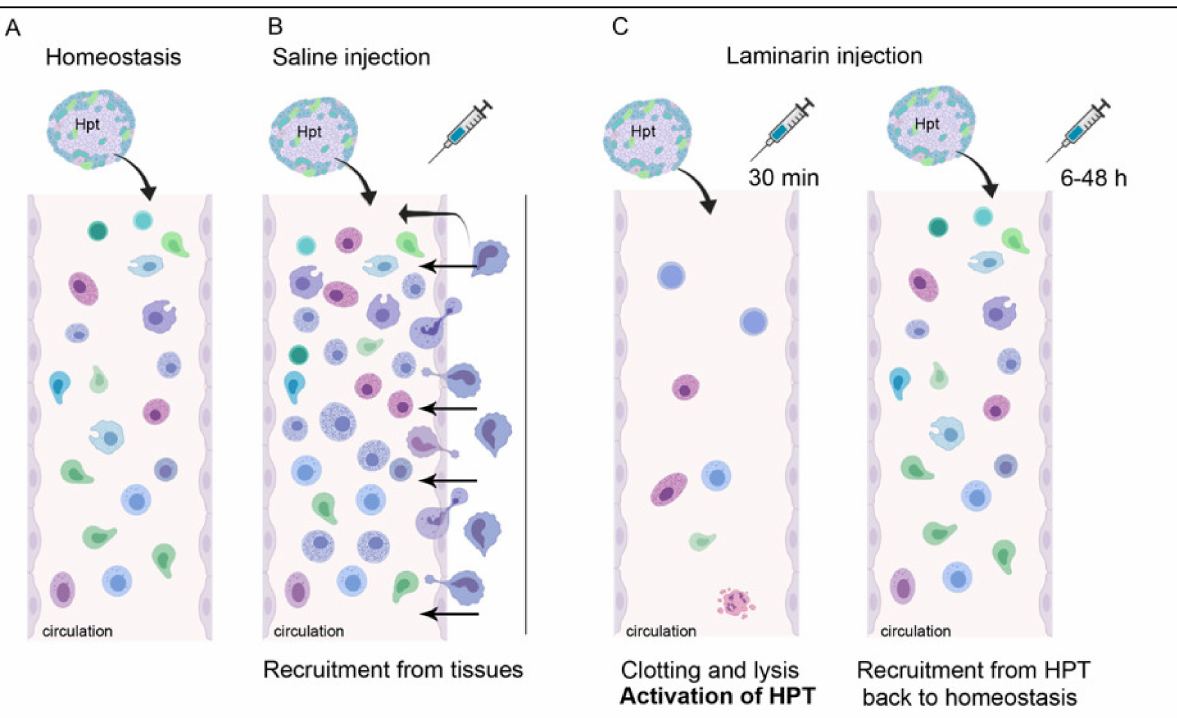
Figure 7. Illustration showing the events in crayfish peripheral circulation after injection of saline or laminarin. ( A ) Normal cell homeostasis in uninjected crayfish. ( B ) Saline injection results in a rapid recruitment of hemocytes, mainly mature GCs from surrounding tissues. ( C ) Laminarin injection causes a dramatic loss of hemocytes due to clotting, lysis and encapsulation of foreign glucan molecules. At the same time cytokines are released (i.e., astakine 1) into the plasma and induce high activity in the hematopoietic tissue (HPT) with release of new cells and also increased proliferation as we have earlier shown [22]. This figure was created with